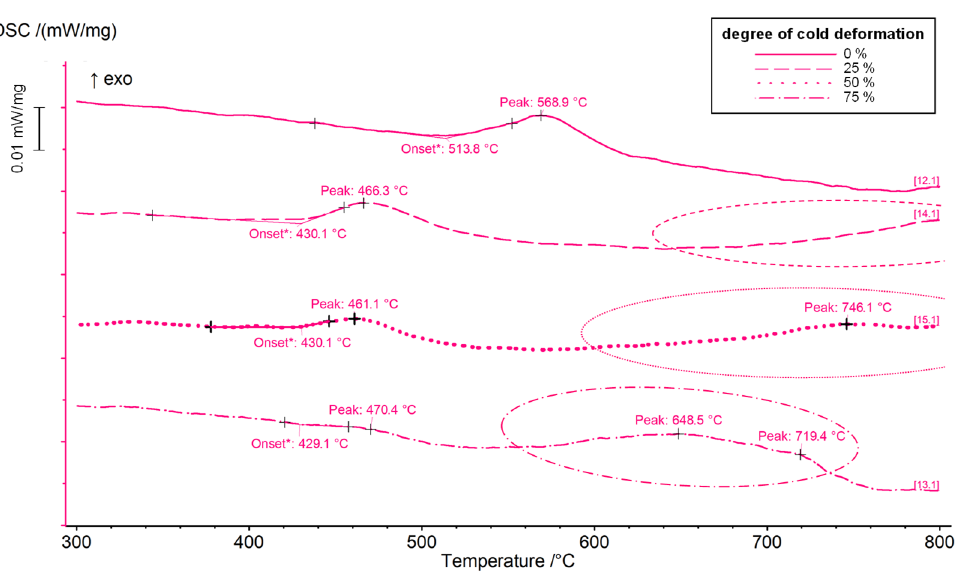
Figure 7. DSC measurement of CuSc0.3 with 0% (solid line), 25% (dashed line), 50% (dotted line), and 75% (dot-dashed line) cold rolling with peak and onset temperatures for the precipitation effect, as well as the area of recrystallization.